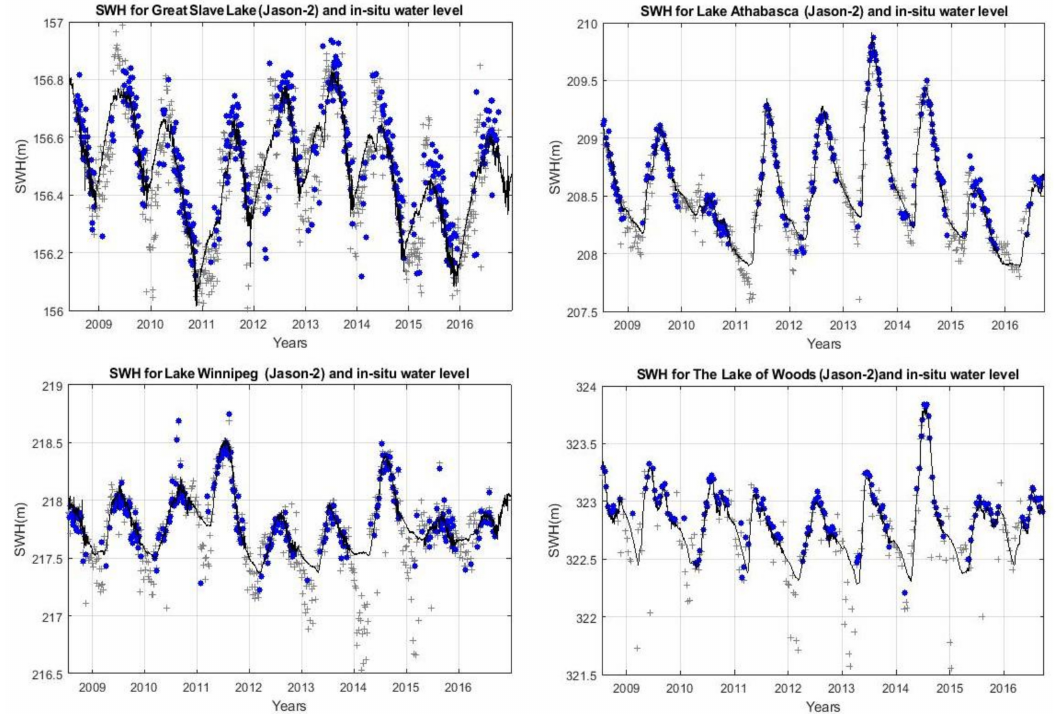
Figure 10. Temporal variation of Surface Water Height obtained from Jason-2 on selected Lakes: results without thresholding method (grey crosses) and results with thresholding method (blue circles) versus in situ water level (black